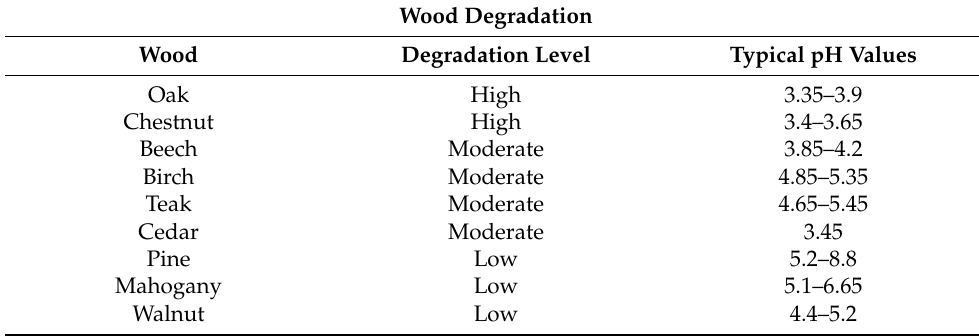
Table 1. Degradation level of different woods under typical pH values